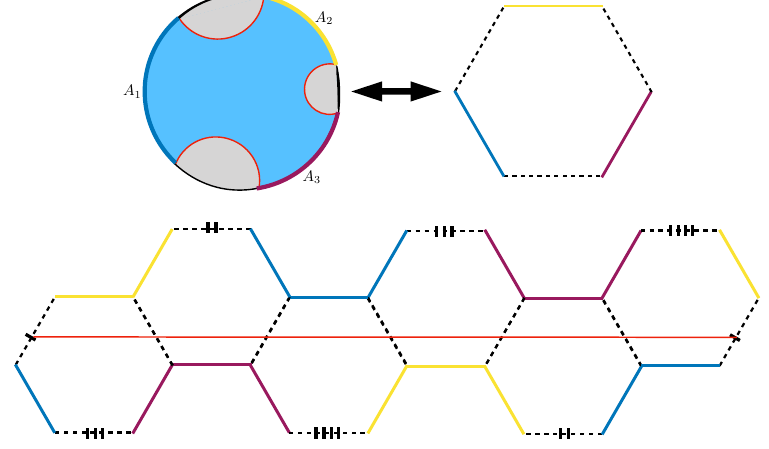
Figure 10 . Top: we can represent each copy of the entanglement wedge as a hexagon. Bottom: the six copies from figure 9 glued to form the manifold P . The solid red line is the resulting representation of Σ on P here called Σ P